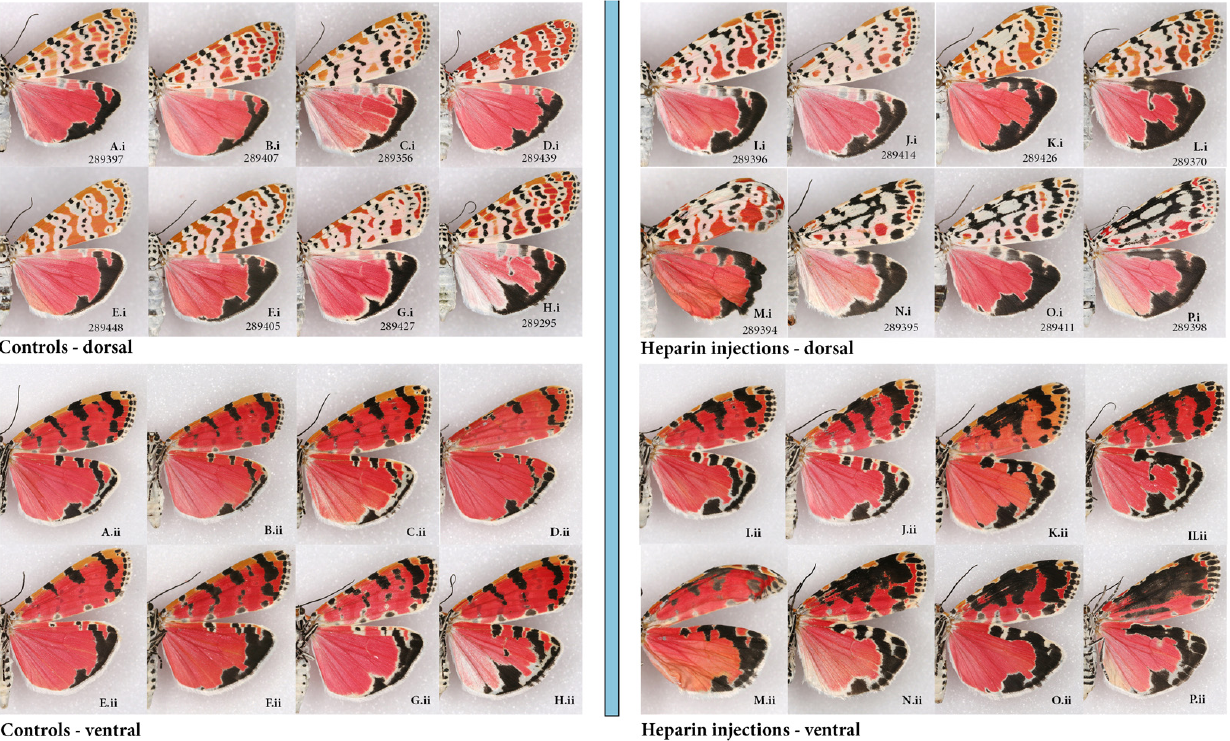
N – 8hBP) or pupae ( J – 14 hAP, L – 17 hAP, O – 19 hAP, P – 12 hAP). Figured in the order of increasing heparin effect. ( i ) dorsal ( ii ) ventral C ode following voucher # indicates brood # and sex (m-male, f-female). See Extended Data (Sourakov, 2020) for details.